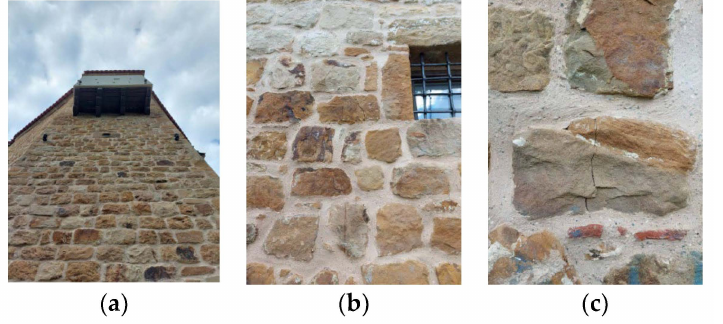
Figure 15. The use of the different types of stone on the Tower Motrilja. ( a ) On-site view. ( b ) Stone stack detail. ( c ) Deteriorated elements in the tower (Photo source: Branko